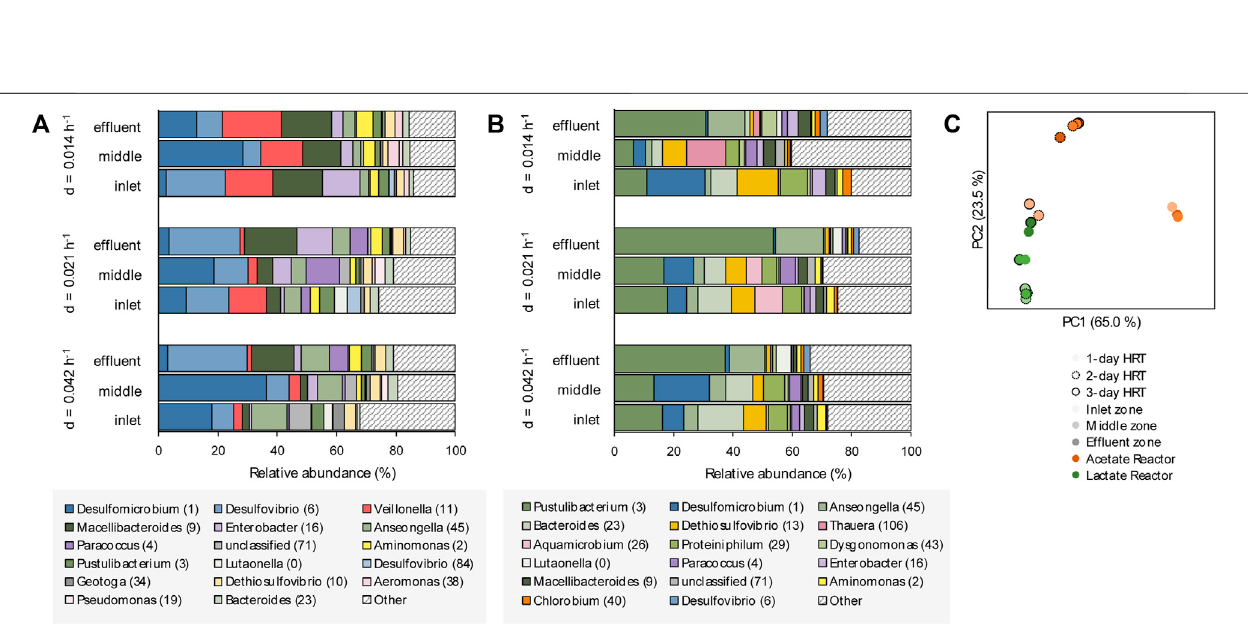
Frontiers in Bioengineering and Biotechnology |